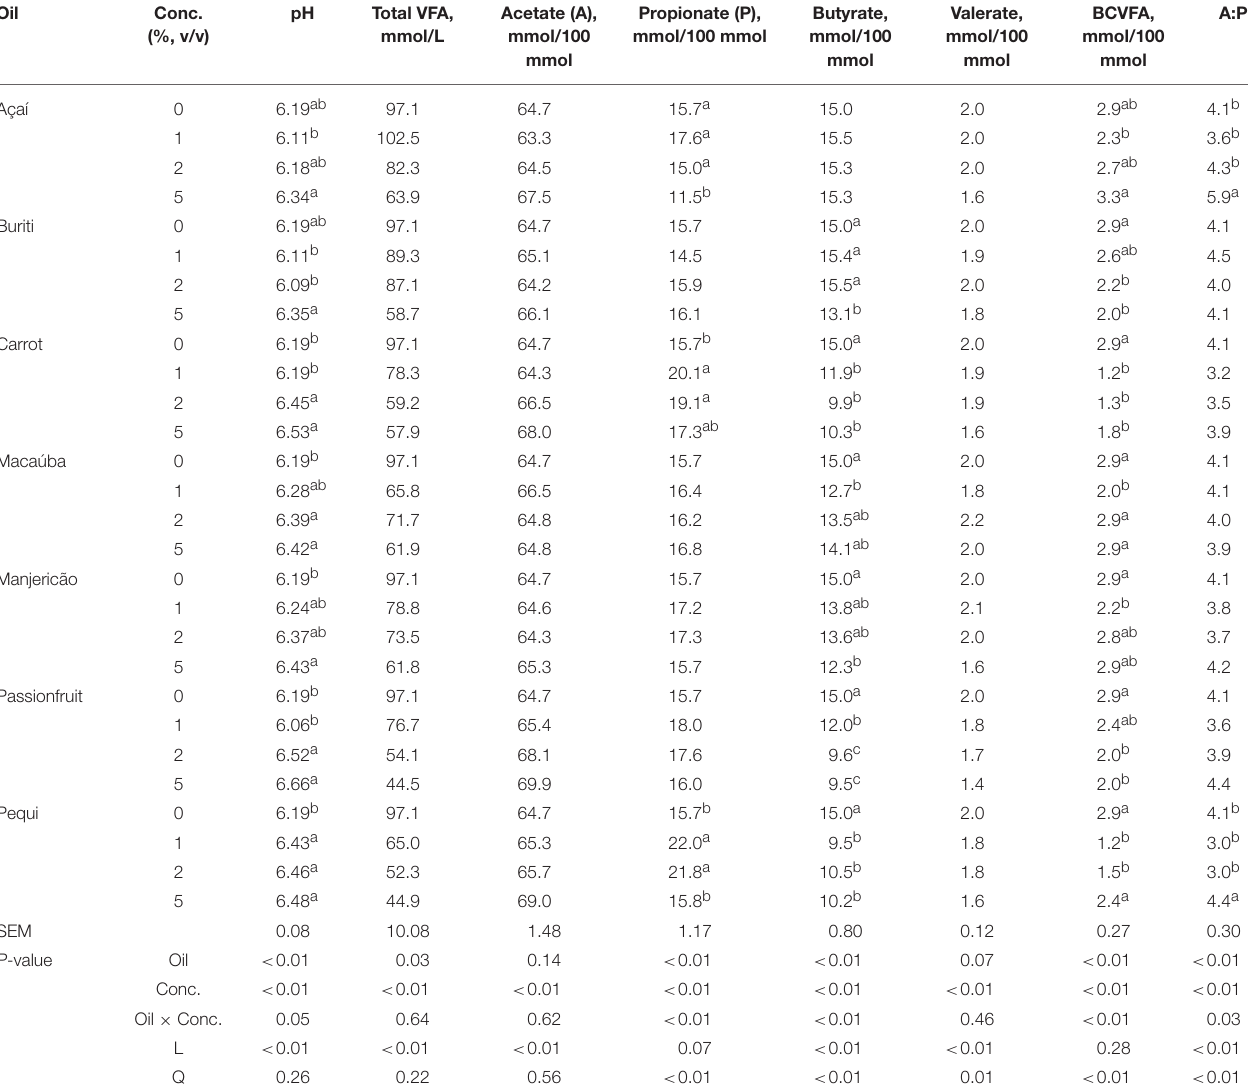
TABLE 5 | Effect of different oils on pH and the volatile fatty acids (VFA) concentrations in an in vitro batch culture using a hay-based diet. Oil Conc. (%, v/v)